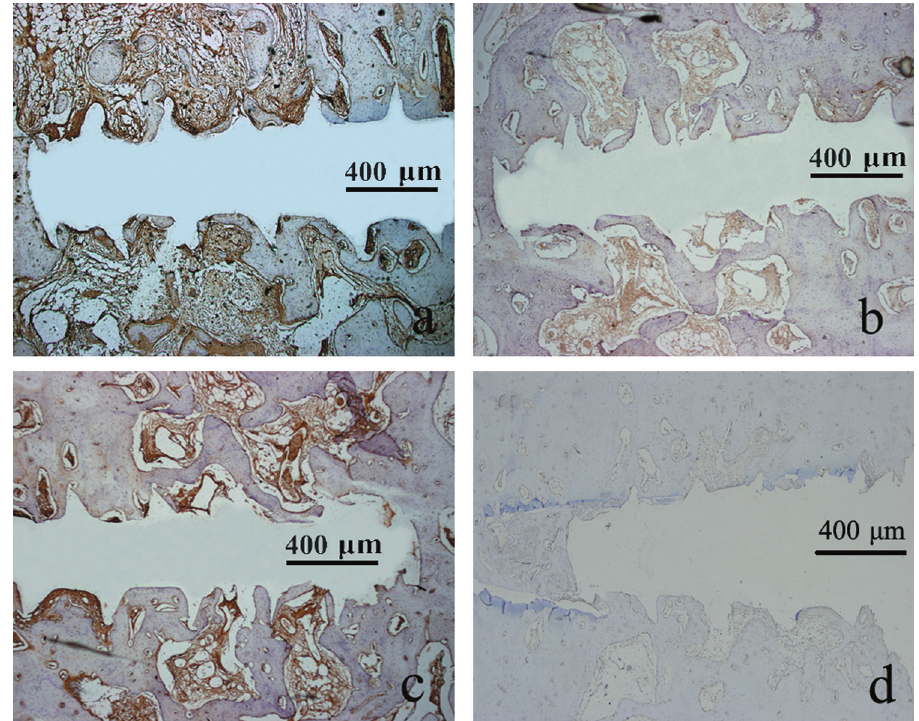
Figure 8- Immunohistochemical staining of TGF-β in sections from beagle mandible from test (a and b) and control group (c and d), during weeks 3 and 8. The expression of TGF-β in test group reached the peak values at week 3 (a). The expression in control groups was low at week 1 (d) and reached the peak values at week 8 (c). There were statistically significant differences between two groups at week 3. The values in test group were higher than in control group